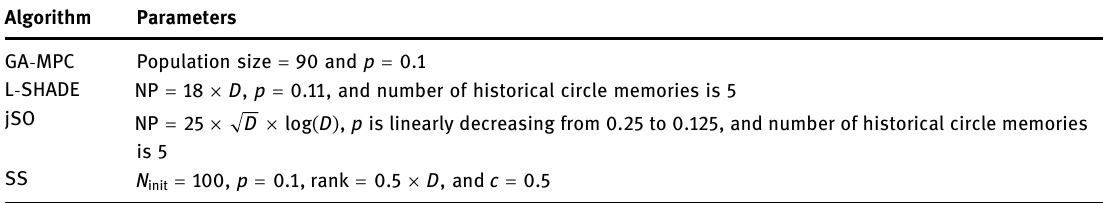
Table 13: Parameter settings for the state - of - the - art approaches Algorithm